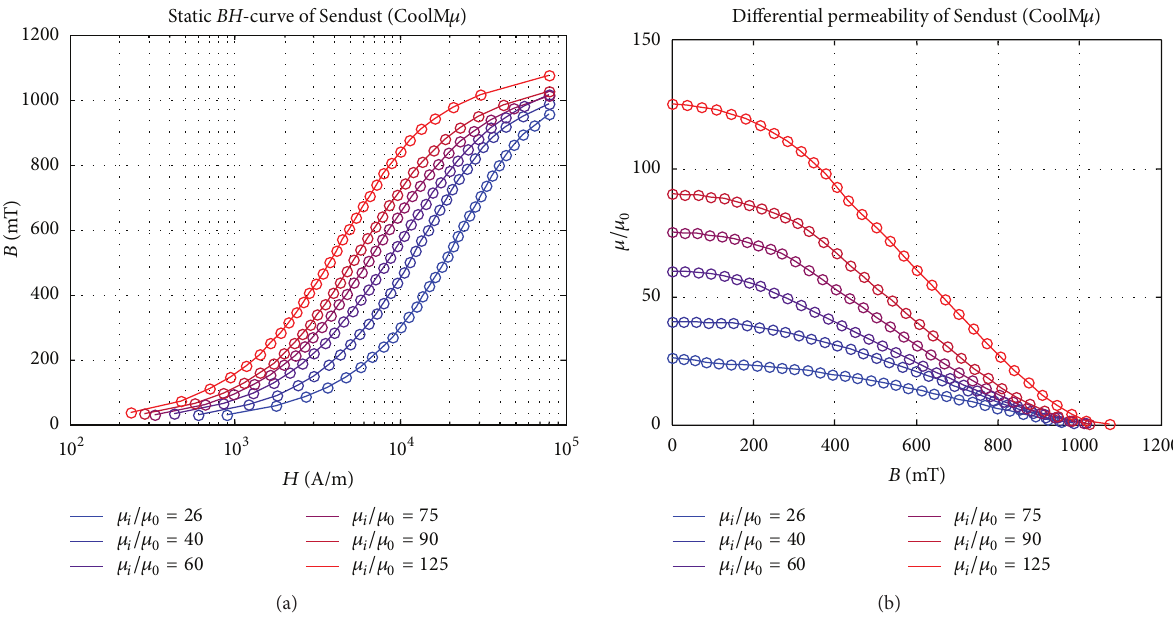
Figure 5: Measured static BH -curves (a) and differential permeabilities (b) of Sendust (CoolM 𝜇 ) metal powder with different permeability